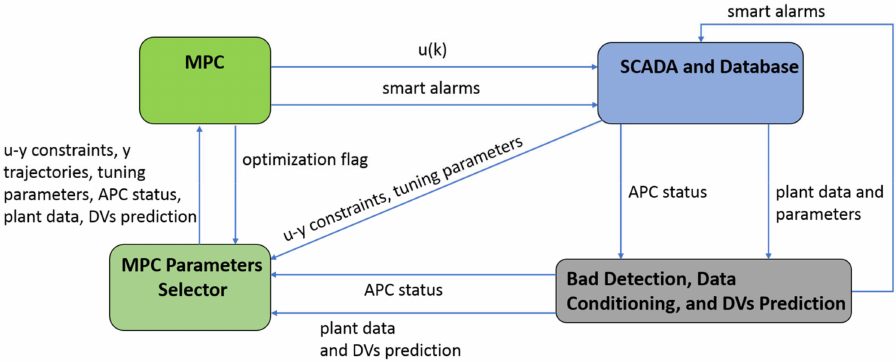
Figure 7. Schematic representation of the APC system’s